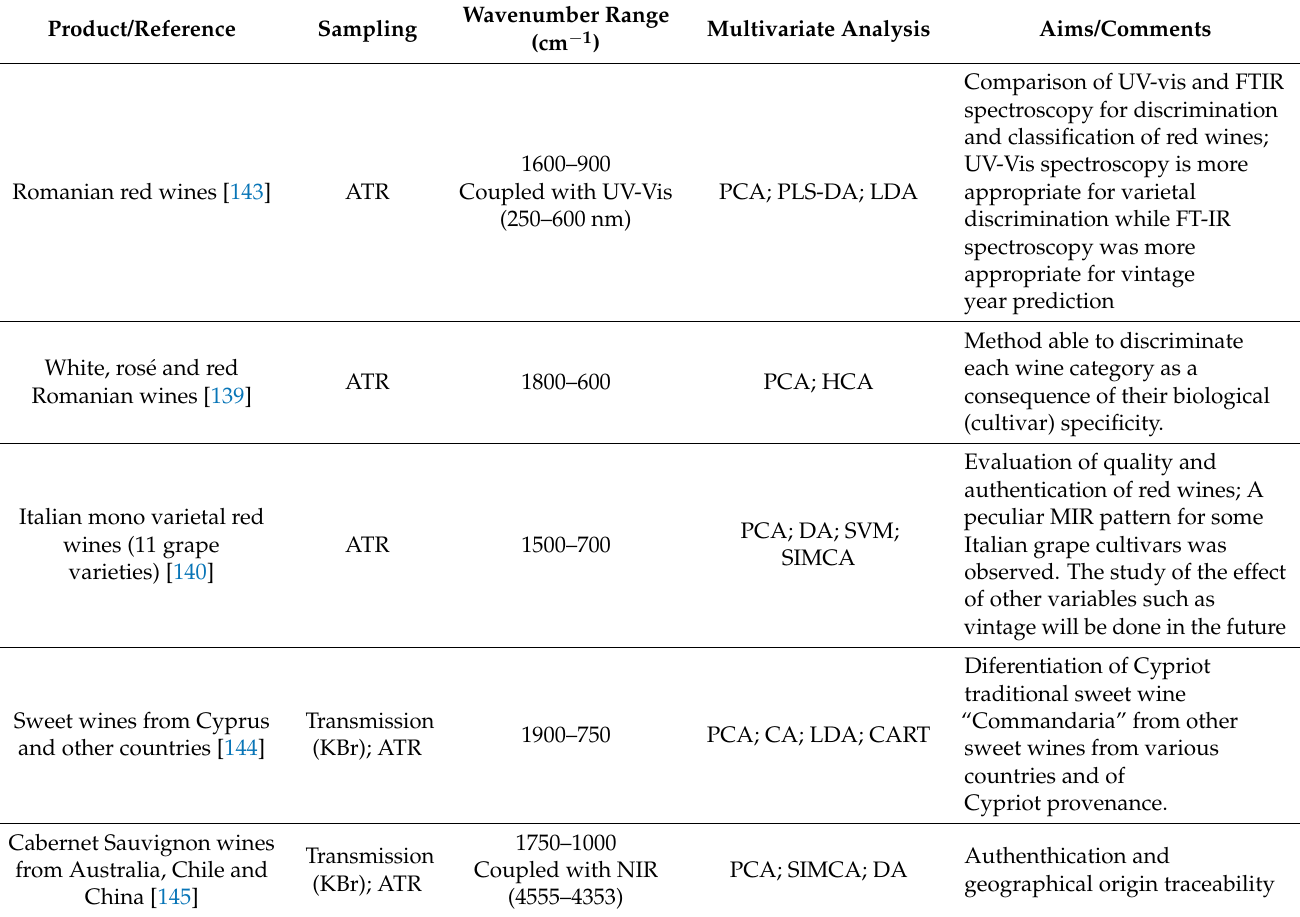
Table 7. Application of FT-MIR spectroscopy to the analysis of